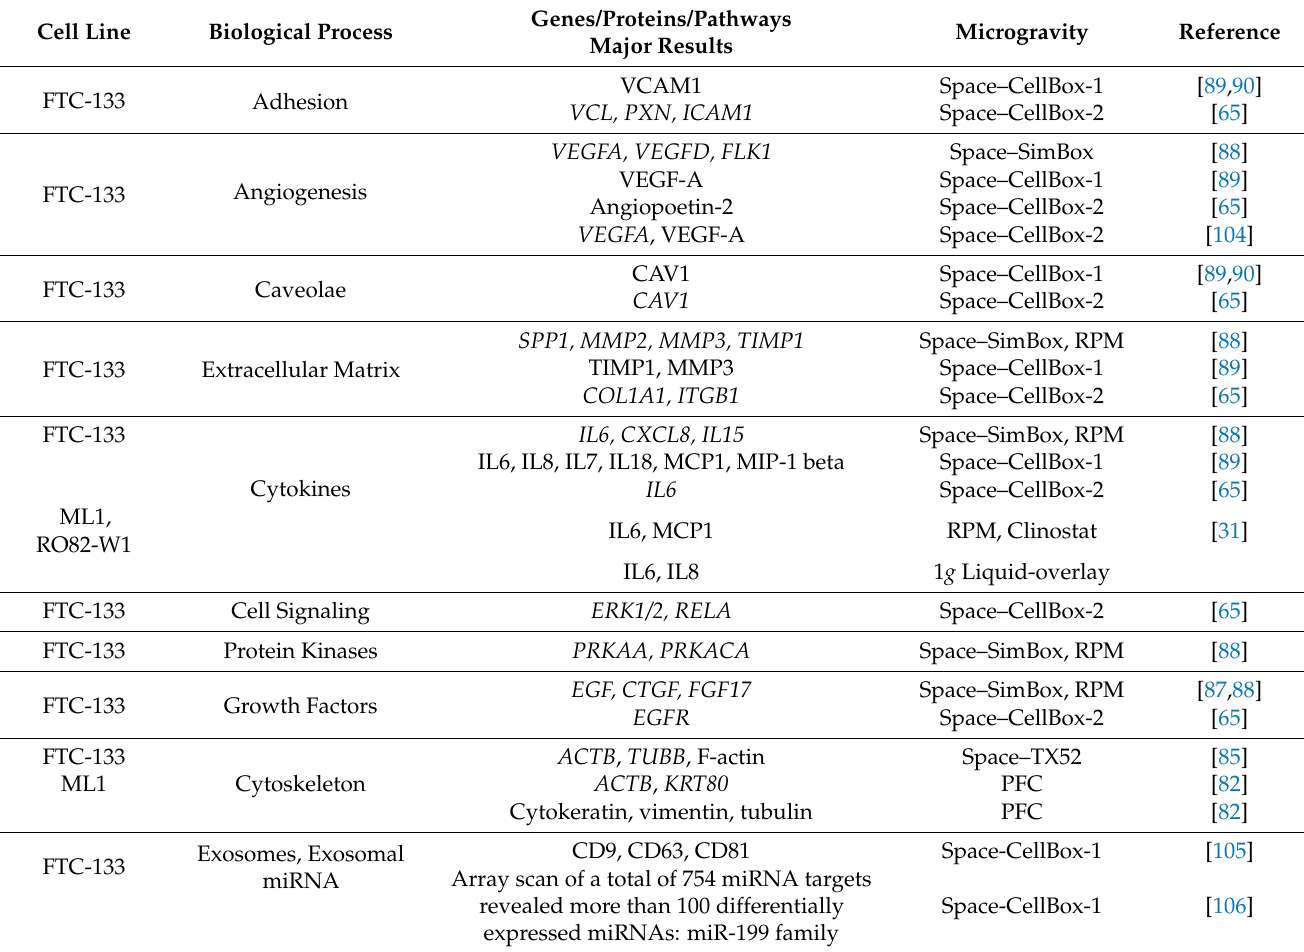
Table 1. Overview of Results of Studies with Thyroid Cancer